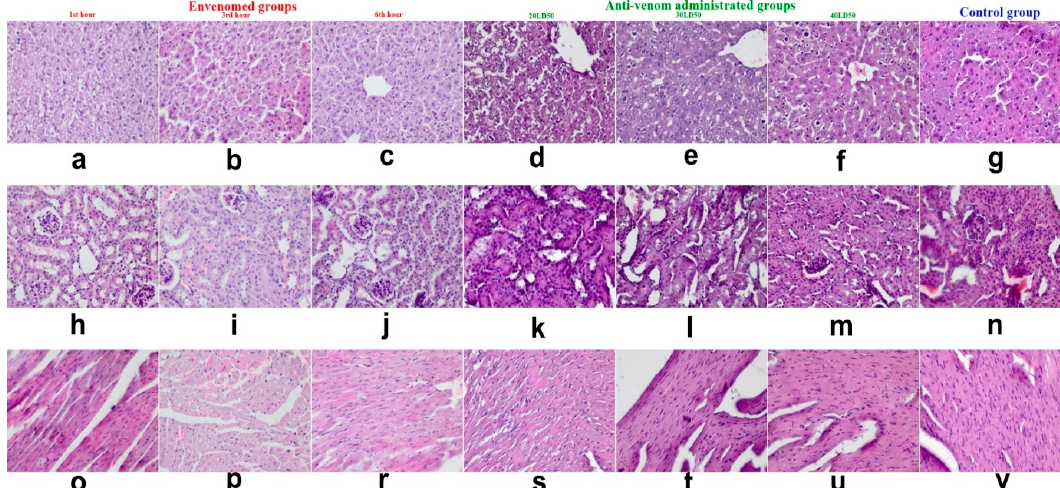
Figure 1. Description of degeneration in liver in envenomed groups ( a – c ) and anti-venom groups ( d – f ), control group ( g ); kidneys in envenomed groups ( h – j ) and antivenom groups ( k – m ), control group ( n ); heart in envenomed groups ( o – r ) and antivenom groups ( s – u ), control group ( v ), x400, Hematoxylin-Eosin (H&E) staining.